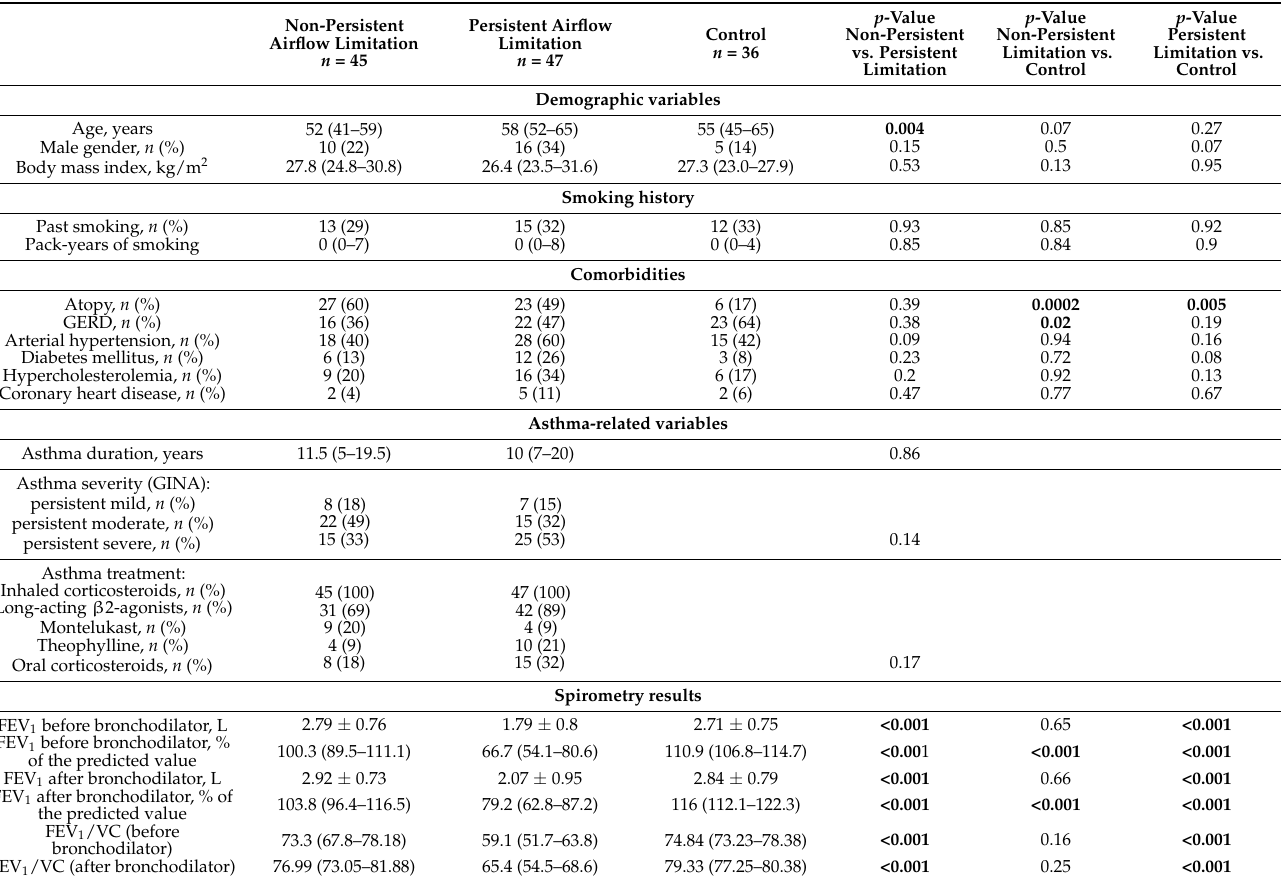
Table 1 footnote. Categorical variables are presented as numbers (percentages), continuous variables as median and interquartile range, or mean and standard deviation, as appropriate. Abbreviations: GERD—Gastroesophageal reflux disease, GINA—Global Initiative